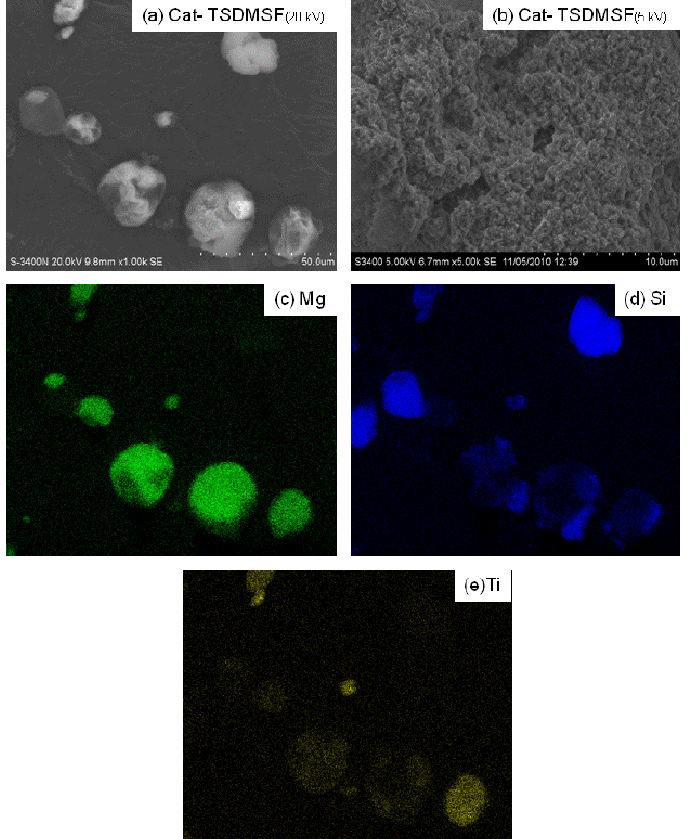
Figure 5. SEM micrograph and elemental distribution on Cat-TSDMSF; (a) SEM image; (b) external surface; (c) Mg distribution; (d) Si distribution and (e) Ti distribution.